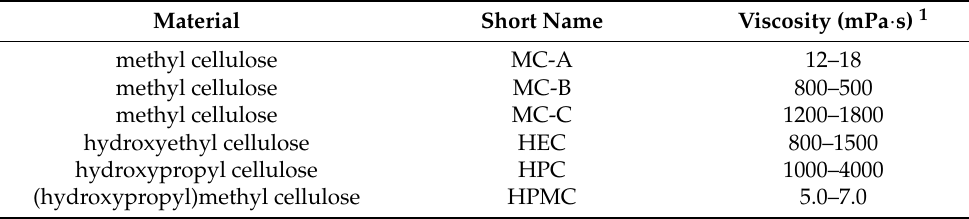
Table 1. List of the different cellulose derivatives considered for the preliminary assessment of this study.